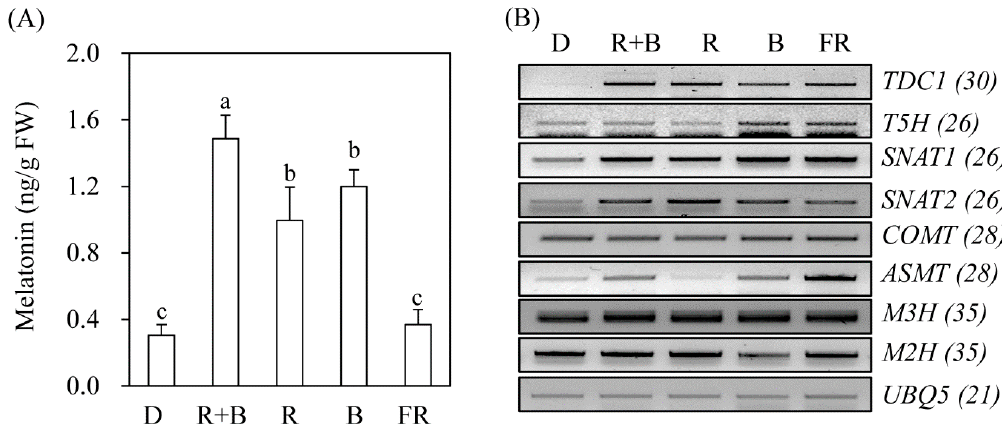
Figure 2. Effects of light wavelength on melatonin synthesis and expression levels of corresponding genes. ( A ) Effects of light quality on melatonin synthesis. ( B ) Expression levels of melatonin biosynthetic and catabolic genes. Dehusked rice seeds were germinated and grown in half-strength Murashige and Skoog (MS) medium for 7 days under continuous light conditions as described in Figure 1. TDC1 , tryptophan decarboxylase 1; T5H , tryptamine 5-hydroxylase; SNAT , serotonin N - acetyltransferase; COM T, caffeic acid O -methyltransferase; ASMT , N -acetylserotonin O -